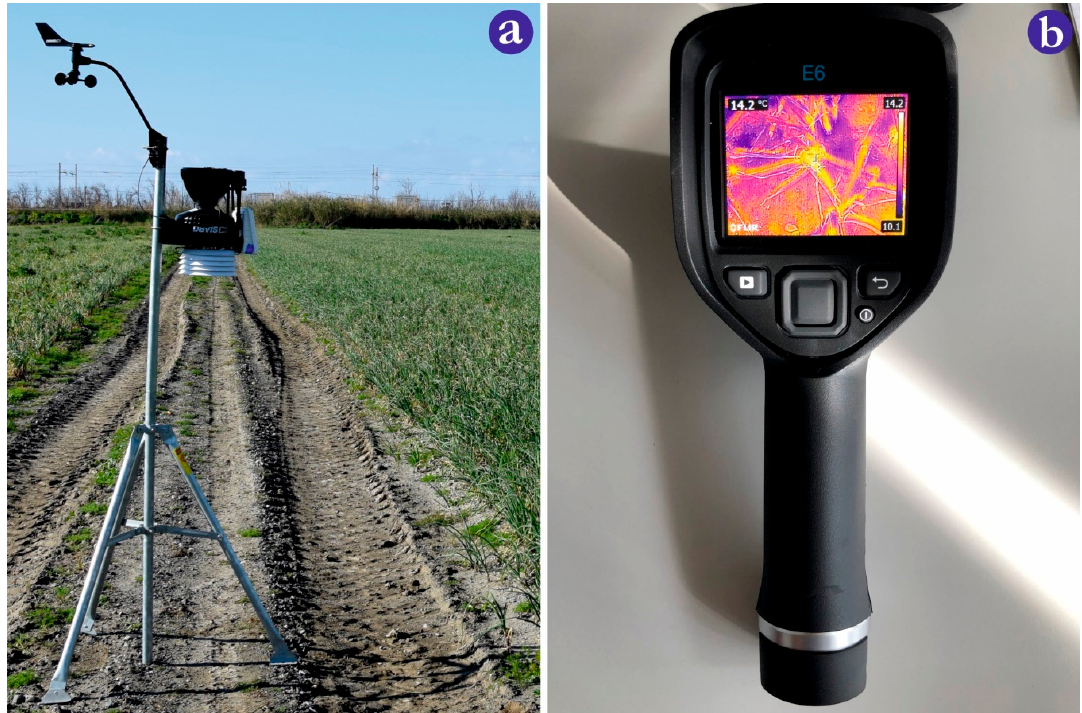
Figure 6. ( a ) The weather station used during the thermal surveys on an onion field. ( b ) Handheld infrared thermometer used to measure the temperature of reference surfaces (photos taken by the